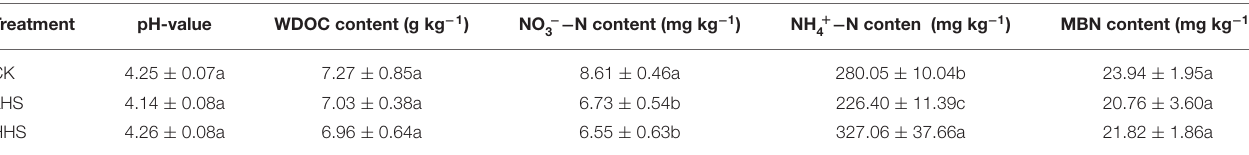
TABLE 1 | pH and nutrient contents of soil at different